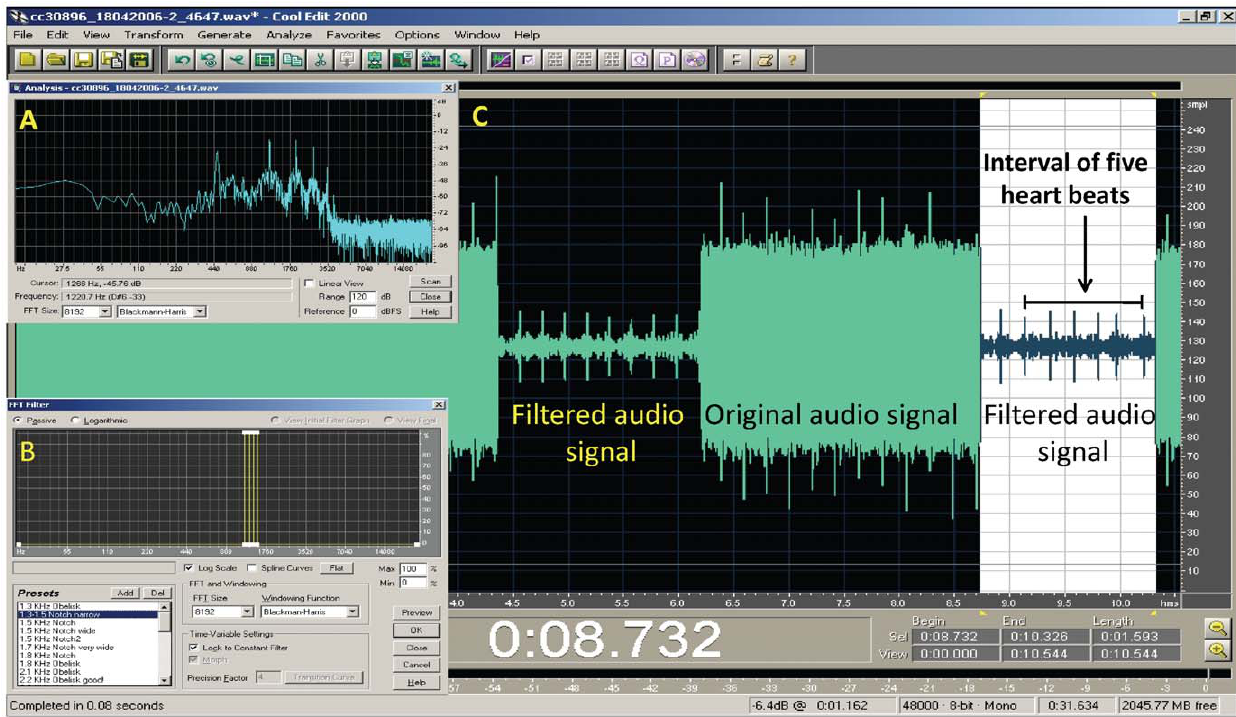
Figure 4. An illustration of heart beat frequency ( f H ) measurement of a European bee-eater using CoolEdit 2000 H software. (A) Frequency analysis of the focal audio segment. (B) Application of fast Fourier transform filter according to the frequency analysis of the segment to increase the signal-to-noise ratio. (C) Measuring the time interval of five consecutive heart beats on the computer screen from which f H in beats min 2 1 was calculated.